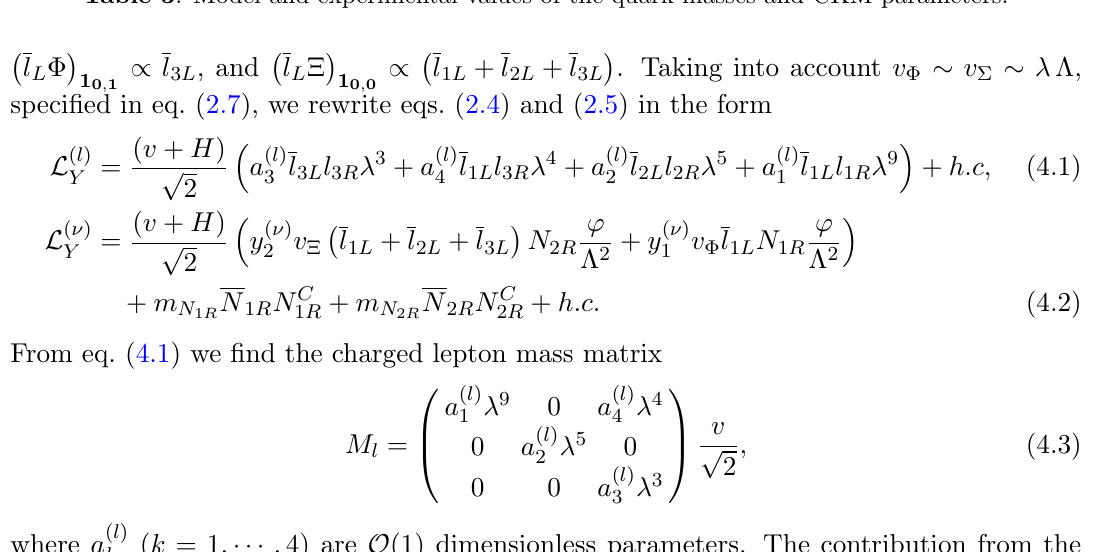
Table 3 . Model and experimental values of the quark masses and CKM